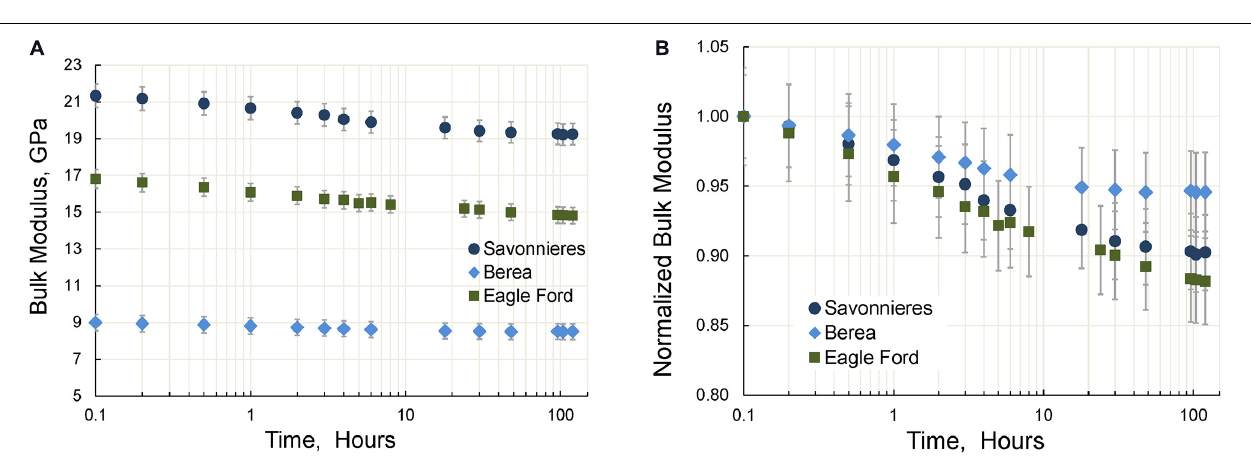
FIGURE 7 | The time dependencies of the bulk (A) and normalized bulk (B) moduli of three tested samples. The measurements are conducted at a uniaxial pressure of 10 MPa.